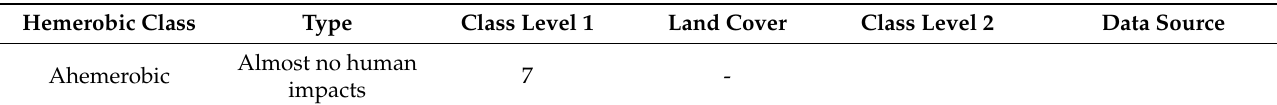
Table A3. Hemerobic reclassification table used for construction of the hemerobic landscape